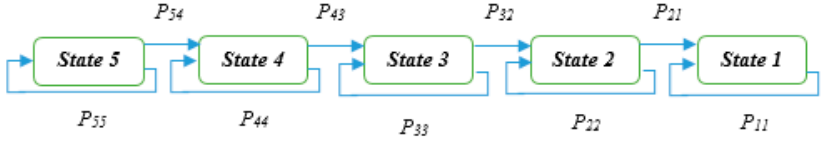
Figure 2. Five-state Markov chain model.